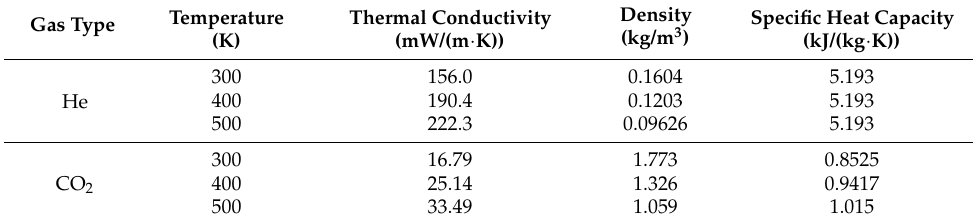
Table 1. Thermal properties of He and CO 2 at p = 1 bar [36].